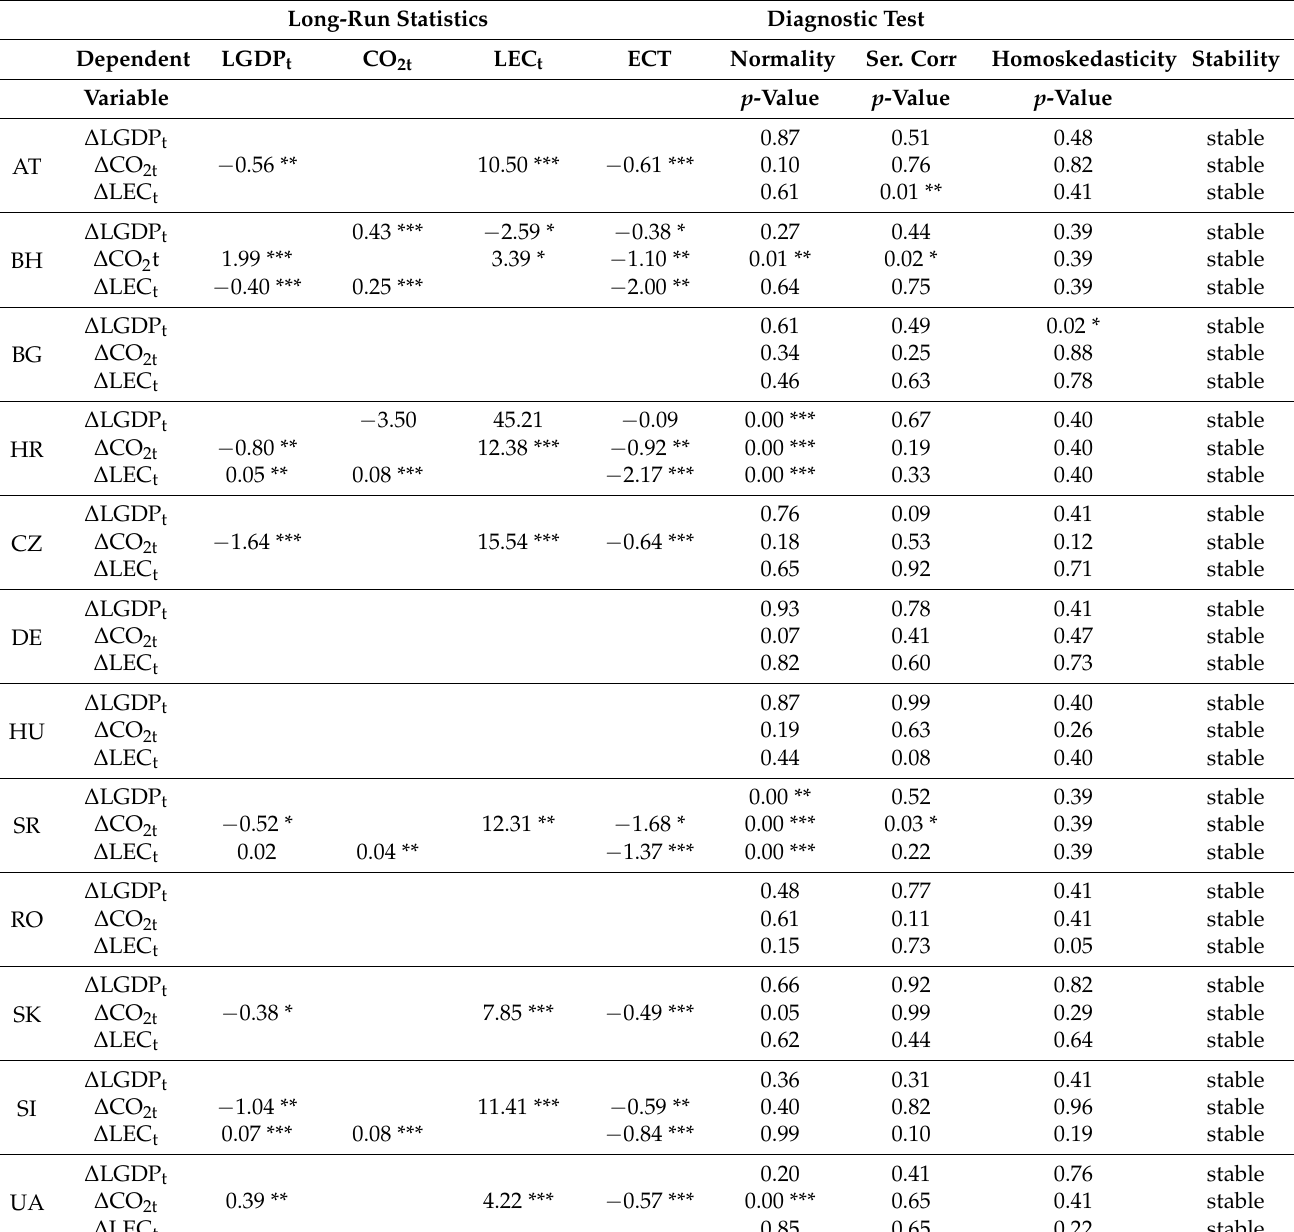
Table 4. Long-run statistics and Diagnostic